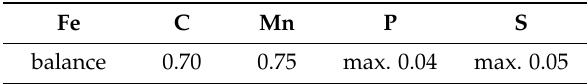
Table 1. Chemical composition of the AISI 1070 steel in wt%.